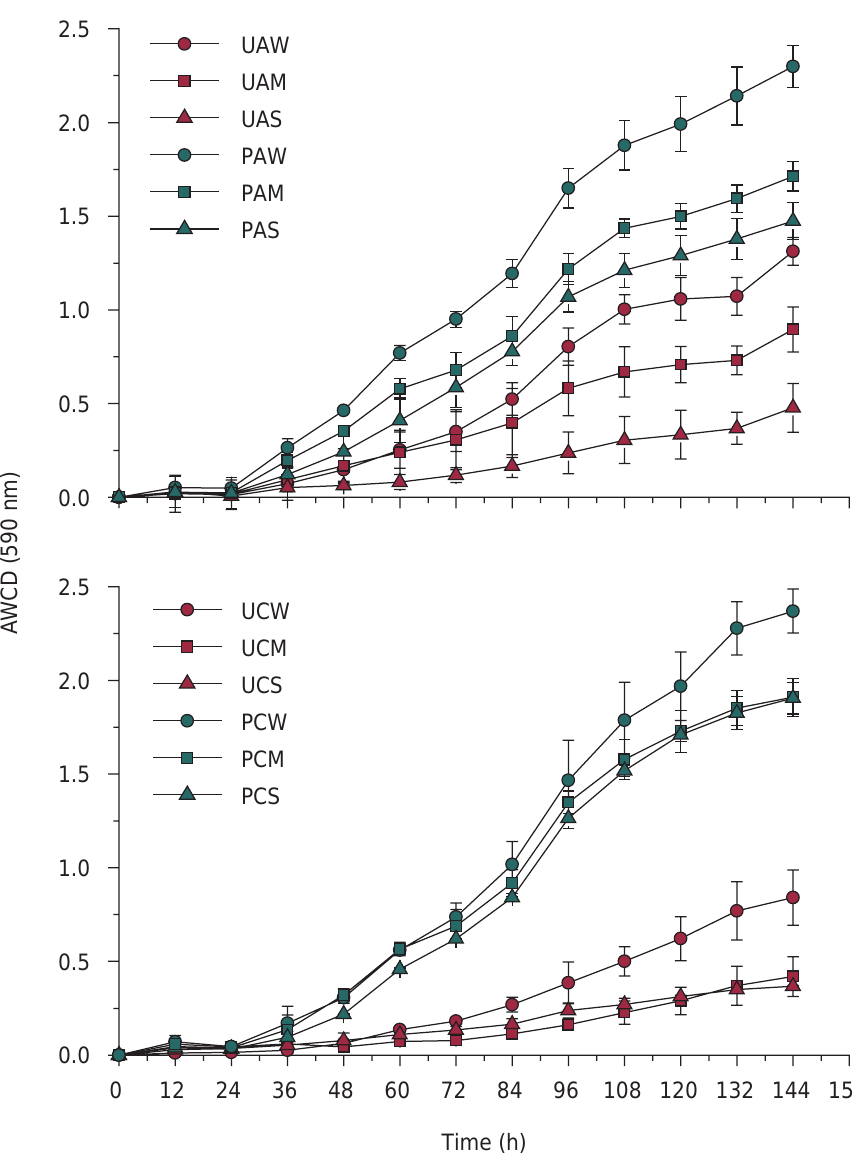
Figure 3. Average well color development (AWCD) of the BIOLOG EcoPlate for different treatments. UAW: unplanted treatment with ambient CO 2 and well-watered condition; UAM: unplanted treatment with ambient CO 2 and mild drought condition; UAS: unplanted treatment with ambient CO 2 and severe drought condition; PAW: planted treatment with ambient CO 2 and well-watered condition; PAM: planted treatment with ambient CO 2 and mild drought condition; PAS: planted treatment with ambient CO 2 and severe drought condition; UCW: unplanted treatment with elevated CO 2 and well-watered condition; UCM: unplanted treatment with elevated CO 2 and mild drought condition; UCS: unplanted treatment with elevated CO 2 and severe drought condition; PCW: planted treatment with elevated CO 2 and well-watered condition; PCM: planted treatment with elevated CO 2 and mild drought condition; PCS: planted treatment with elevated CO 2 and severe drought